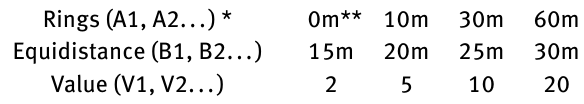
Table 2: Construction parameters of points for the calculation of garden density (* buffer distance, ** edge of